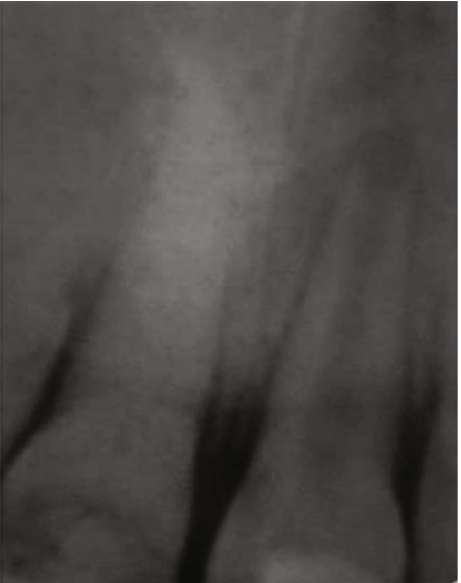
Figure 2: Retroalveolar radiograph showing the calcium hydroxide fi lling of 11.